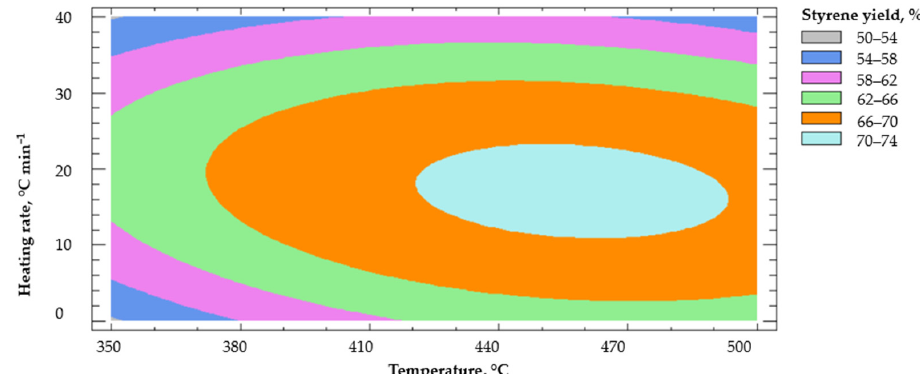
Figure 10. Response surface.